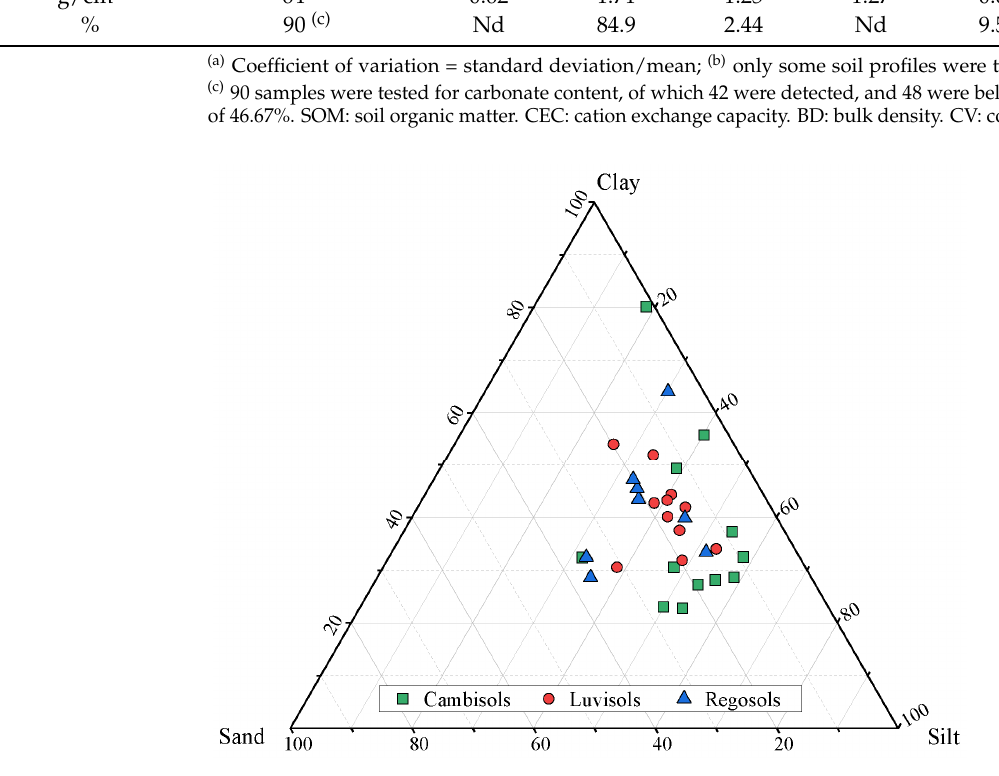
Figure 3. Particle size distributions of soils with different profiles.